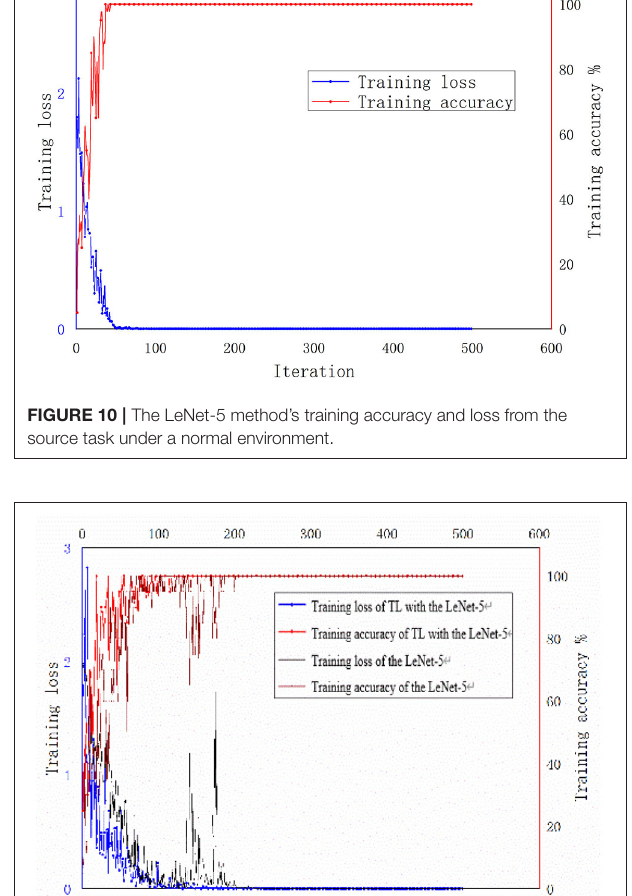
FIGURE 9 | Converted two-dimensional gray images of the gas sensor signals of six modes under a complex environment. (A) Normal signal; (B) The signal including heating wire disconnection (HWD) fault; (C) The signal including aging of the heating wire (AHW) fault; (D) The signal including aging of the sensitive body (ASB) fault; (E) The signal including exfoliation of the sensitive body (ESB) fault; (F) The signal including false welding of the sensitive body (FWSB) fault.